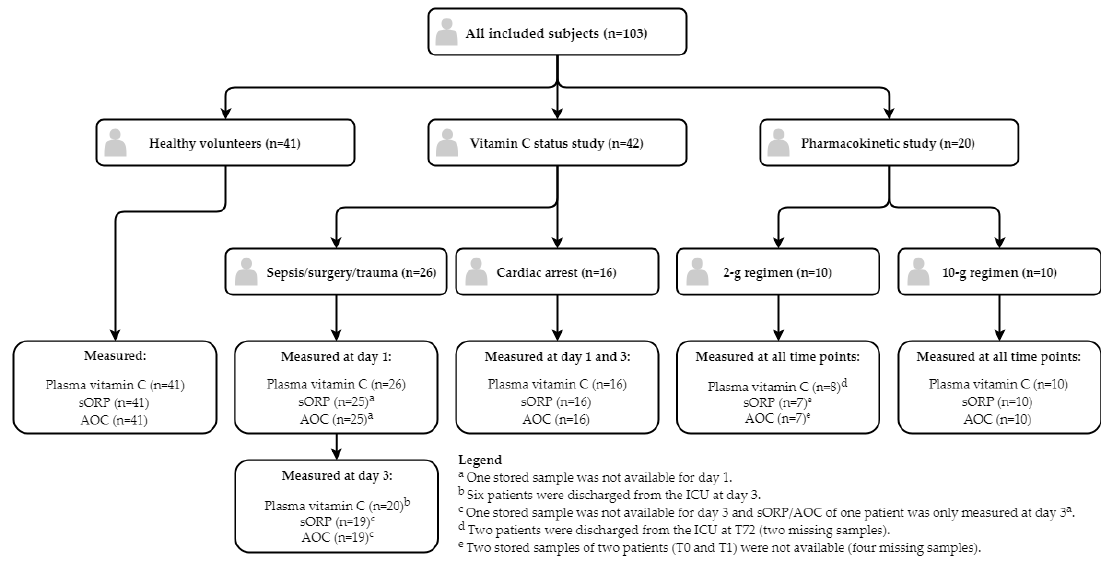
Figure 2. Flowchart of included subjects and sample measurements. Table 2. Baseline characteristics.